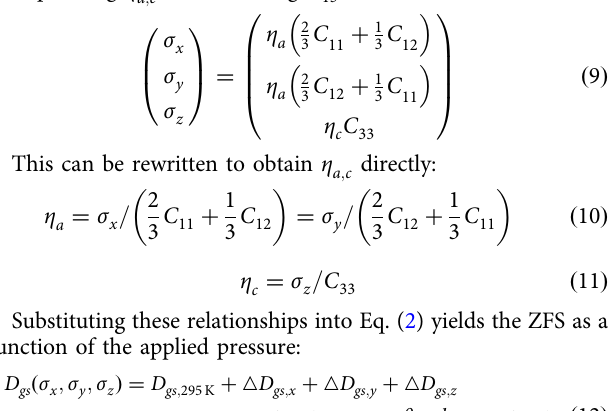
Table 1 Calculated polynomial coef fi cients A